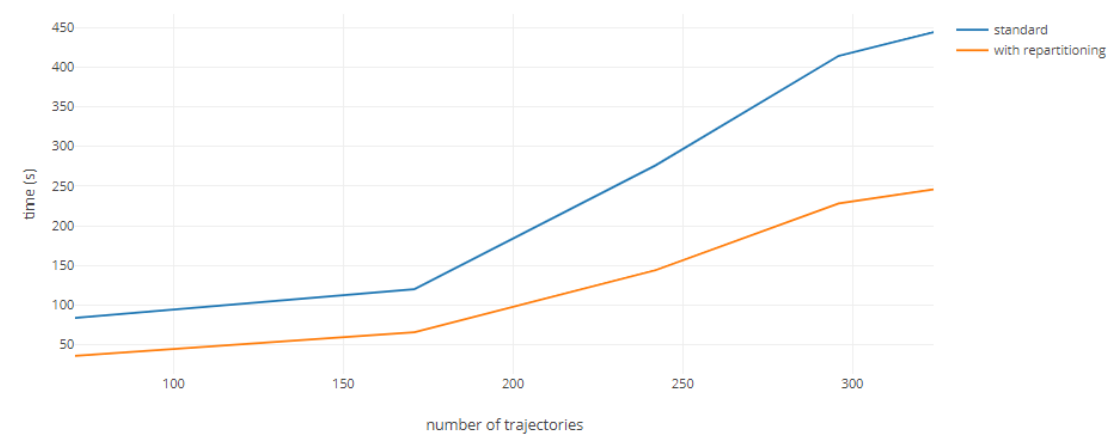
Figure 11. The execution time without and with the repartitioning